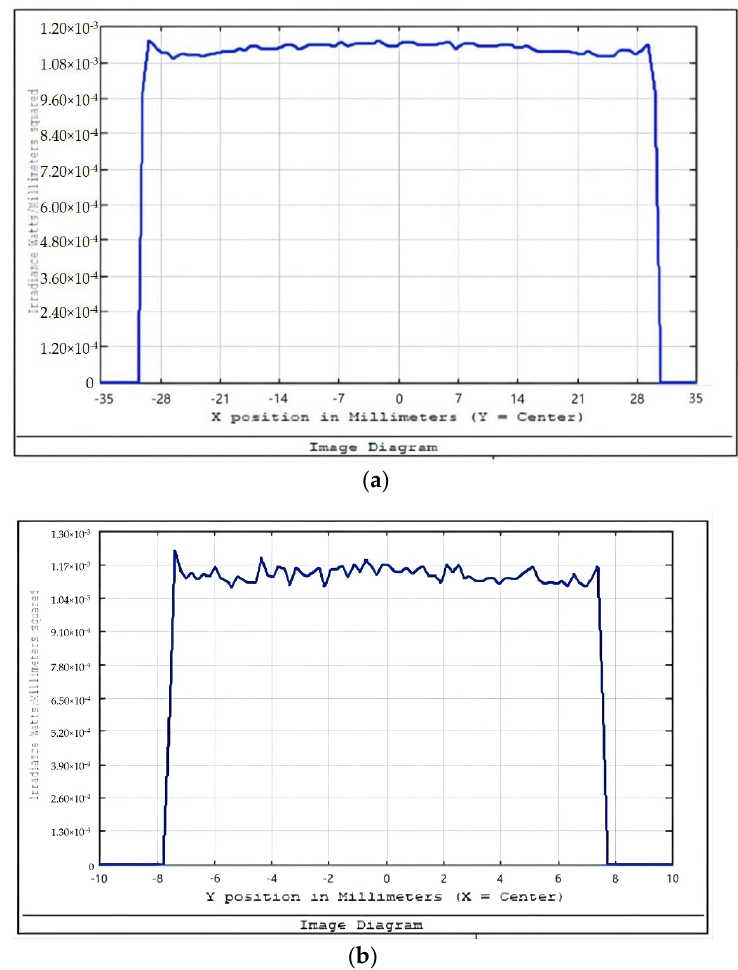
Figure 4. Light-field intensity distribution of the combined optical system. ( a ) The light-field intensity distribution in X. ( b ) The light-field intensity distribution in Y.